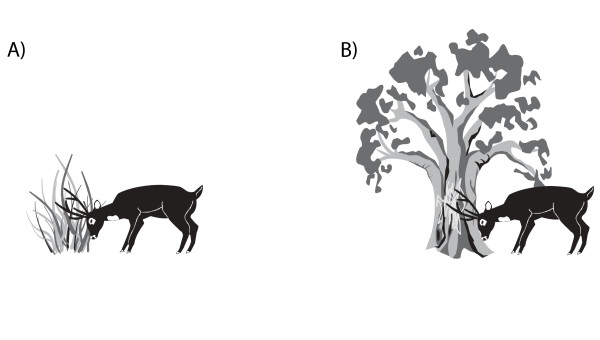
Frontal marking on A) tufts of grass; and B) tree branches.